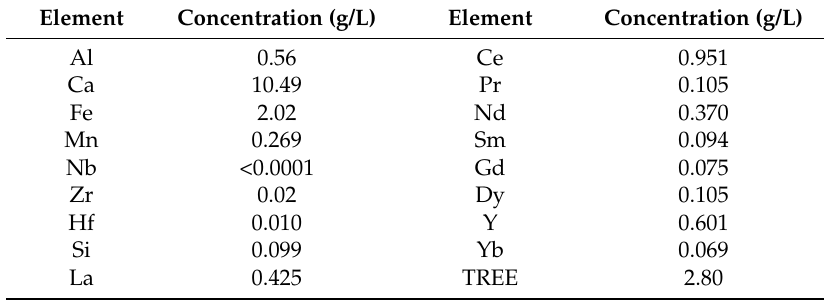
Table 6. Chemical composition of REE enriched solution II in pilot scale-up test.